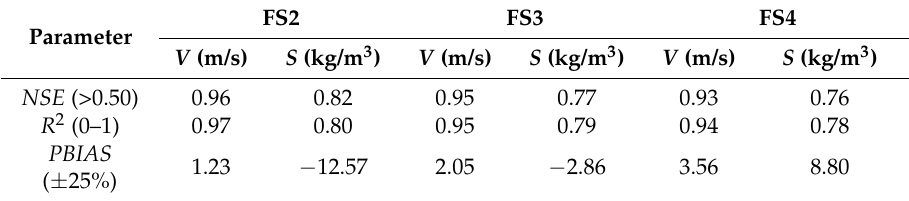
Table 6. Error estimations of model calibration (spring tide, June 2015). FS2 FS3 FS4 Parameter V (m/s) S (kg/m 3